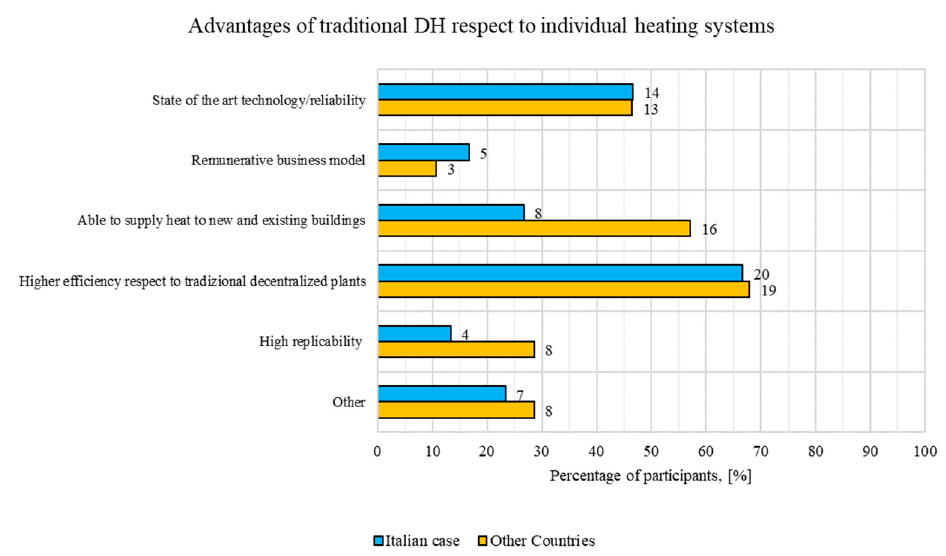
Figure 13. Advantages of traditional DH systems with respect to individual heating systems.